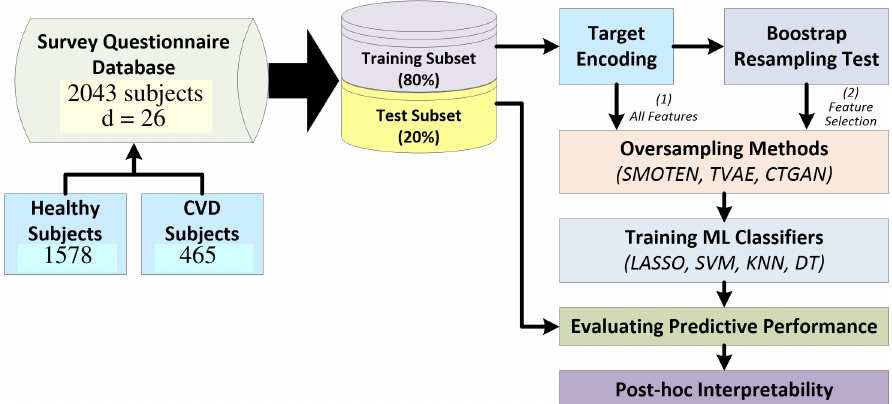
Figure 2. Proposed workflow using oversampling techniques (SMOTEN, TVAE, CTGAN) and different classifiers designed using ML